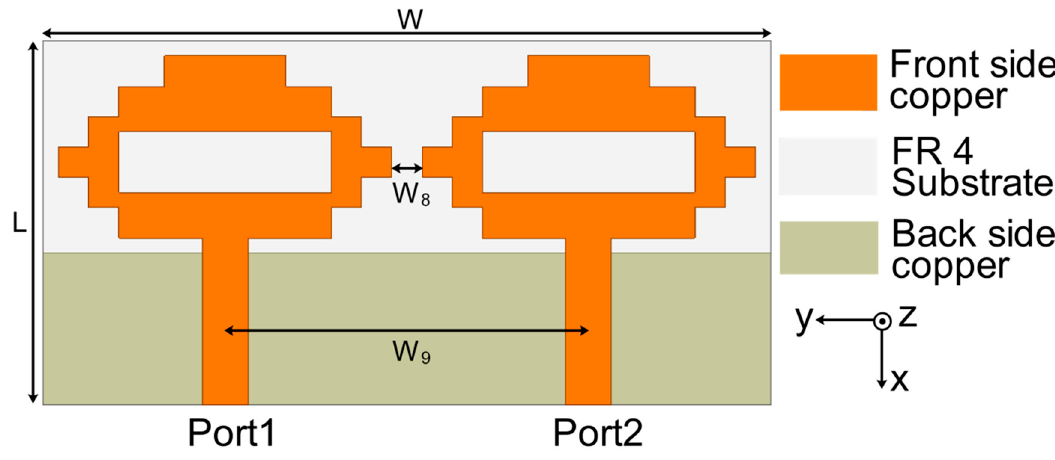
Figure 4. MIMO antenna construction of two elements.